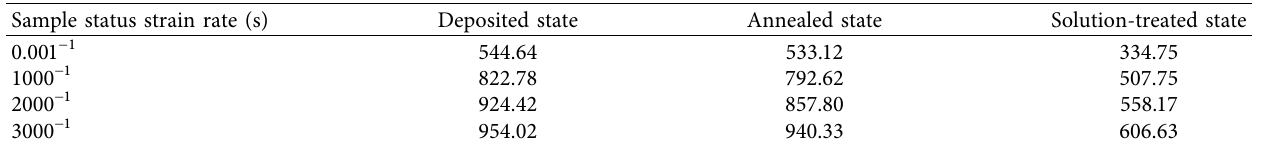
Figure 10: Dynamic stress-strain curve. (a) Deposited state, (b) annealed state, and (c) solution-treated state. Table 4: The trend of the peak yield stress (stress,